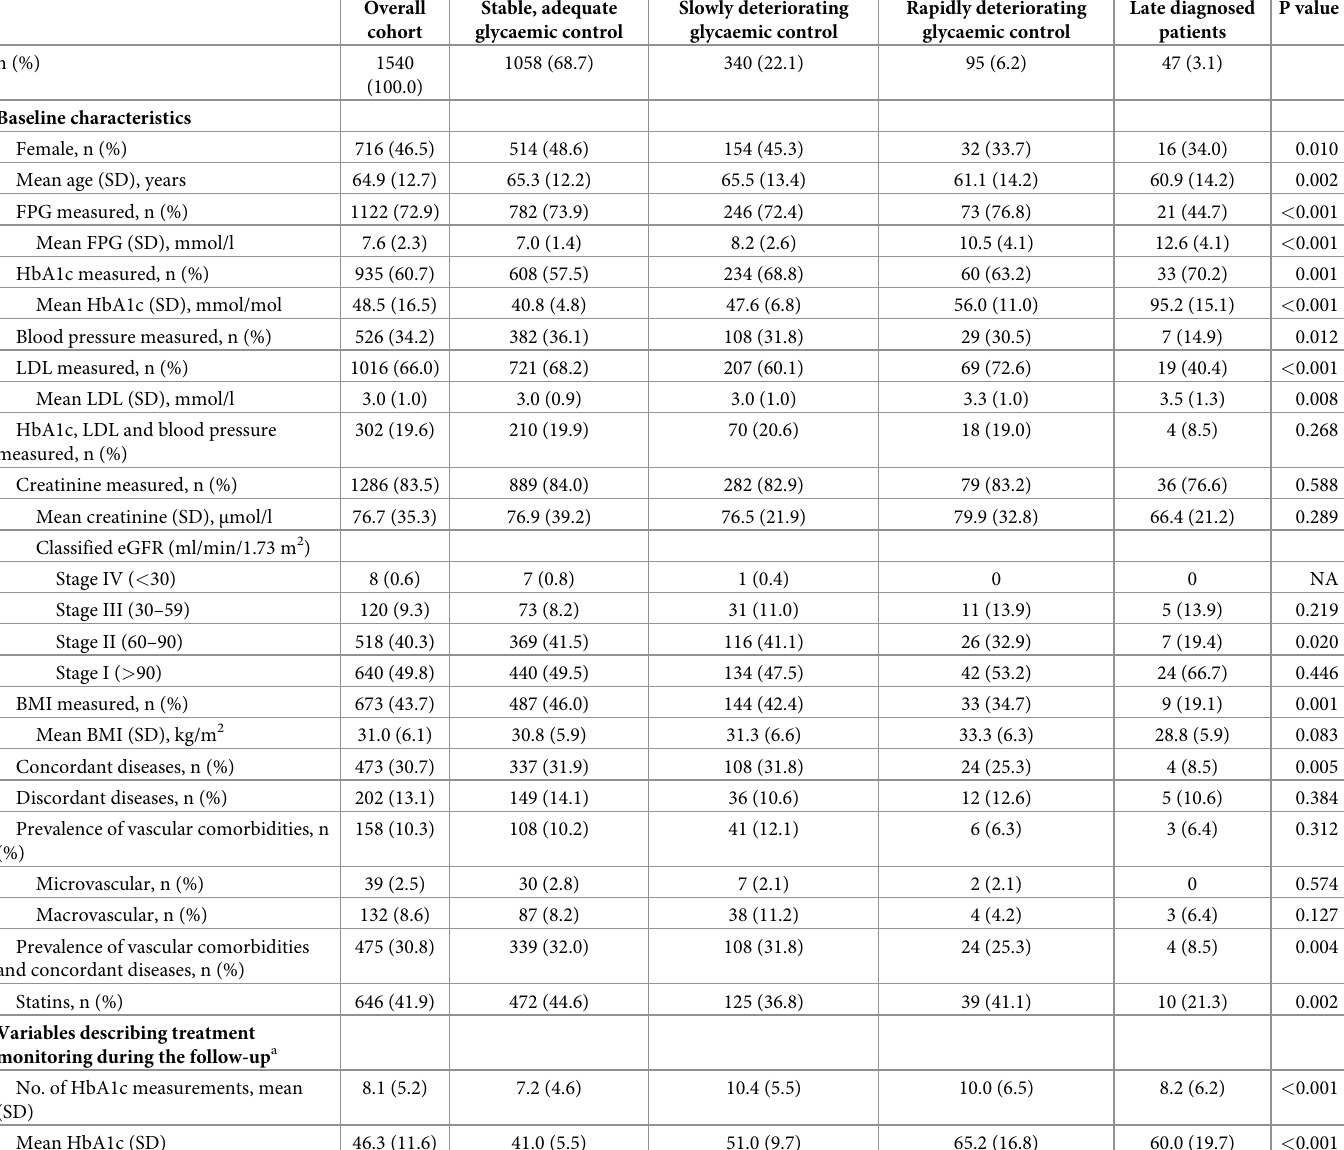
Table 1. Baseline characteristics and variables describing treatment monitoring during the follow-up overall and by the estimated HbA1c